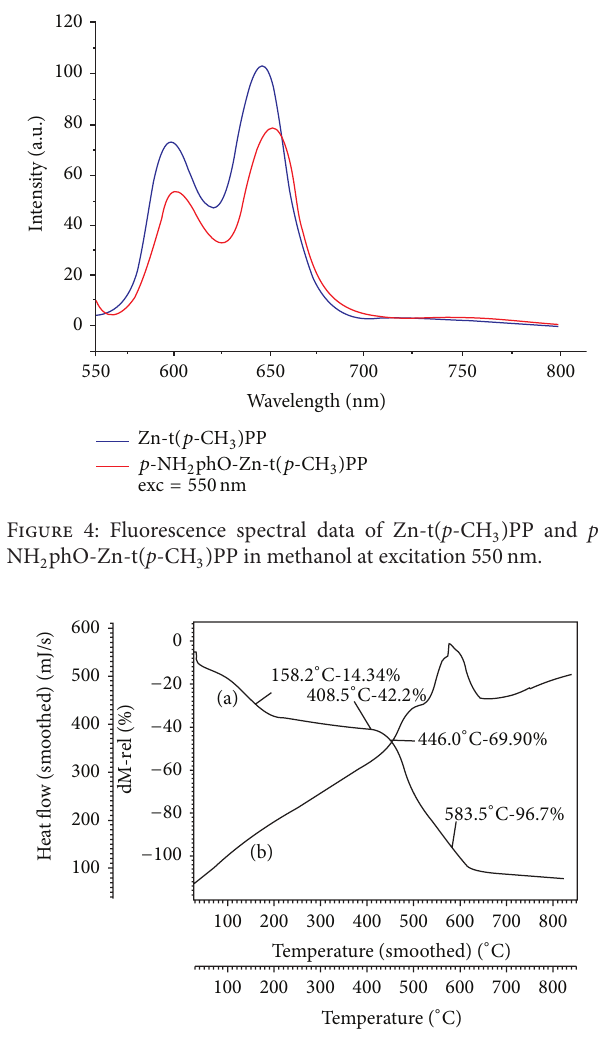
Figure 5: TG curve (a) and DTA curve (b) of p -OCH 3 phO-Zn-t( p - CH 3